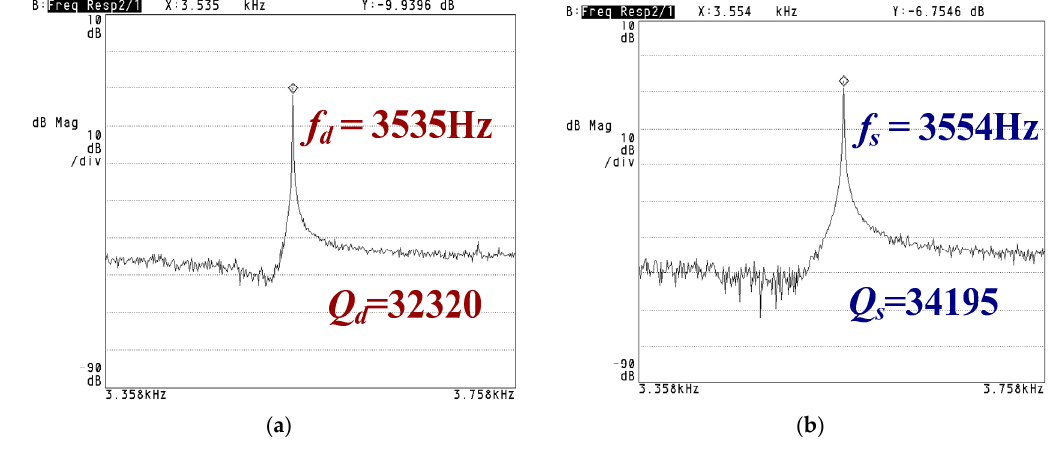
Figure 9. Resonance frequency of the gyroscope: ( a ) drive mode; ( b ) sense mode.